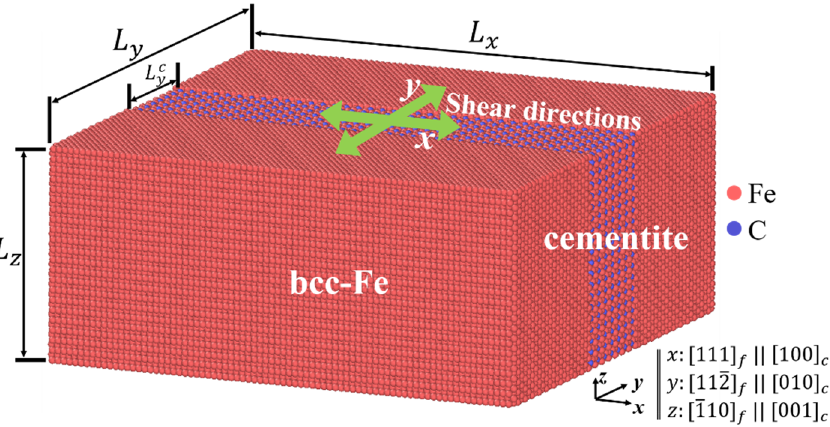
Figure 4. Atomic model of bcc-Fe and cementite, in which f and c represent bcc-Fe and cementite, respectively. Red and blue atoms represent ferrum and carbon atoms, respectively.